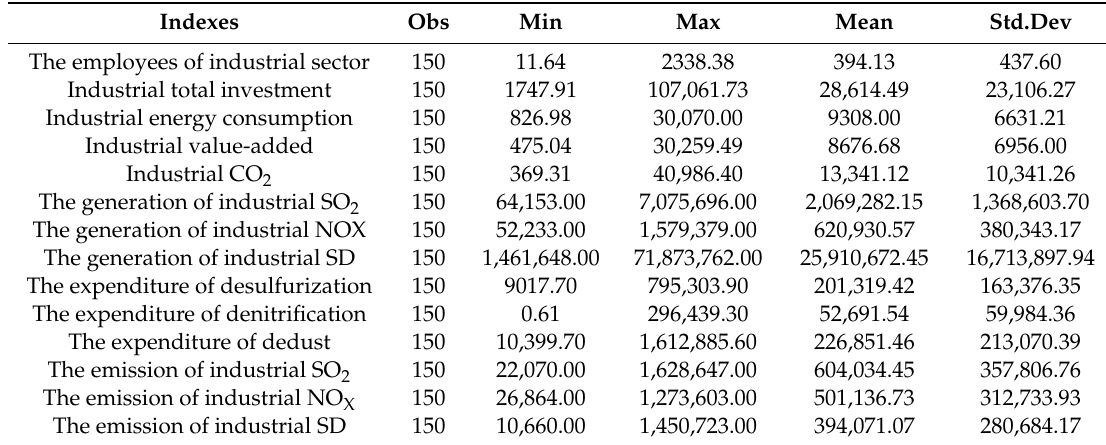
Table 2. Statistical description of